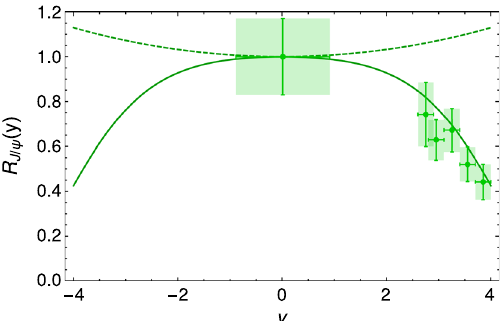
Fig. 5 Rapidity distribution of produced J /ψ . The ratio R J /ψ ( y ) is (cid:2) (cid:3) (cid:2) (cid:3) / d σ J /ψ / dy d σ J /ψ / dy defined as R J /ψ = . The dashed curve y = 0 corresponds to Eq. (35) with BFKL-style parameterization 37 for gluon densities, the solid line takes into account ∼ ( 1 − x ) 5 -endpoint factors as described in the text. The data are taken from Ref.